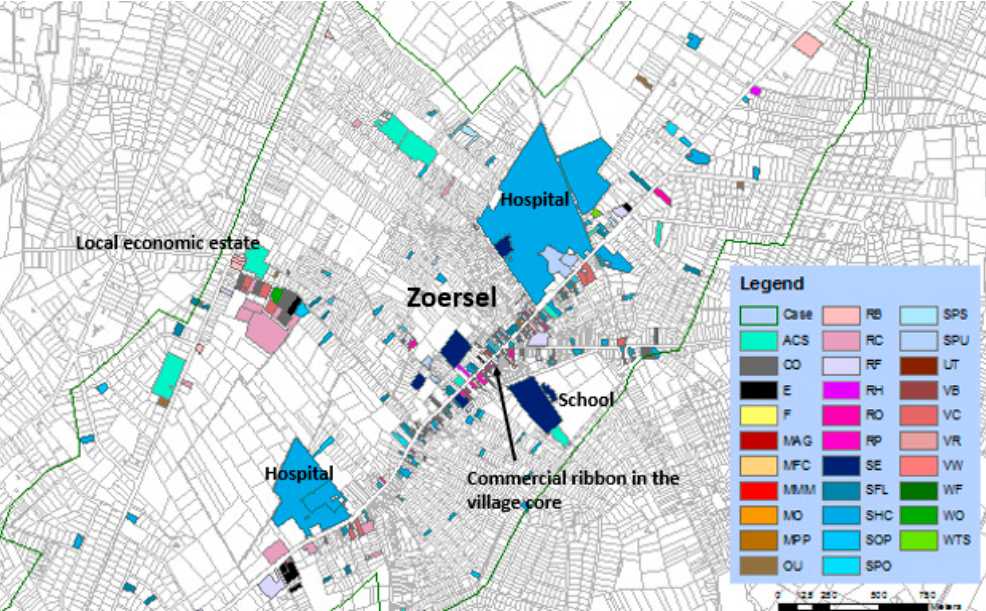
Figure 3. Factual economic use of plots in Zoersel. The activity codes in the legend are: ACS—Arts,